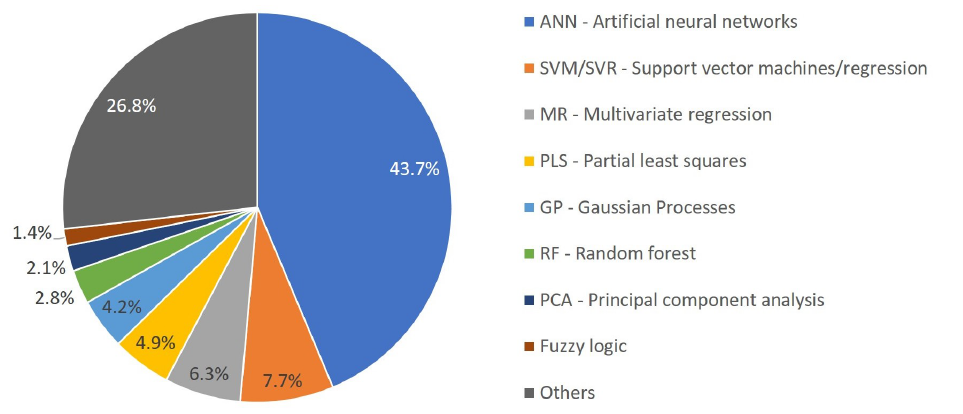
Figure 5. Distribution of ML methods, as part of hybrid modeling approaches, in the reviewed CPE applications.